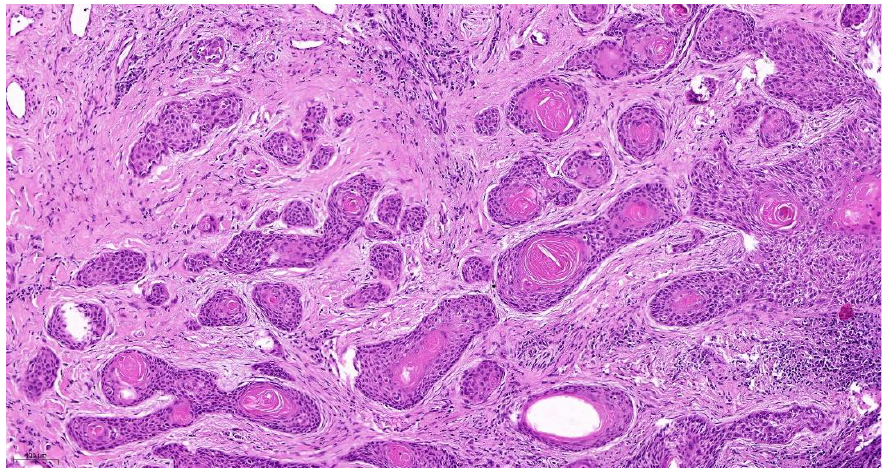
Figure 2. CNS(3) + TB(2) = CDG-2 _10.0×.